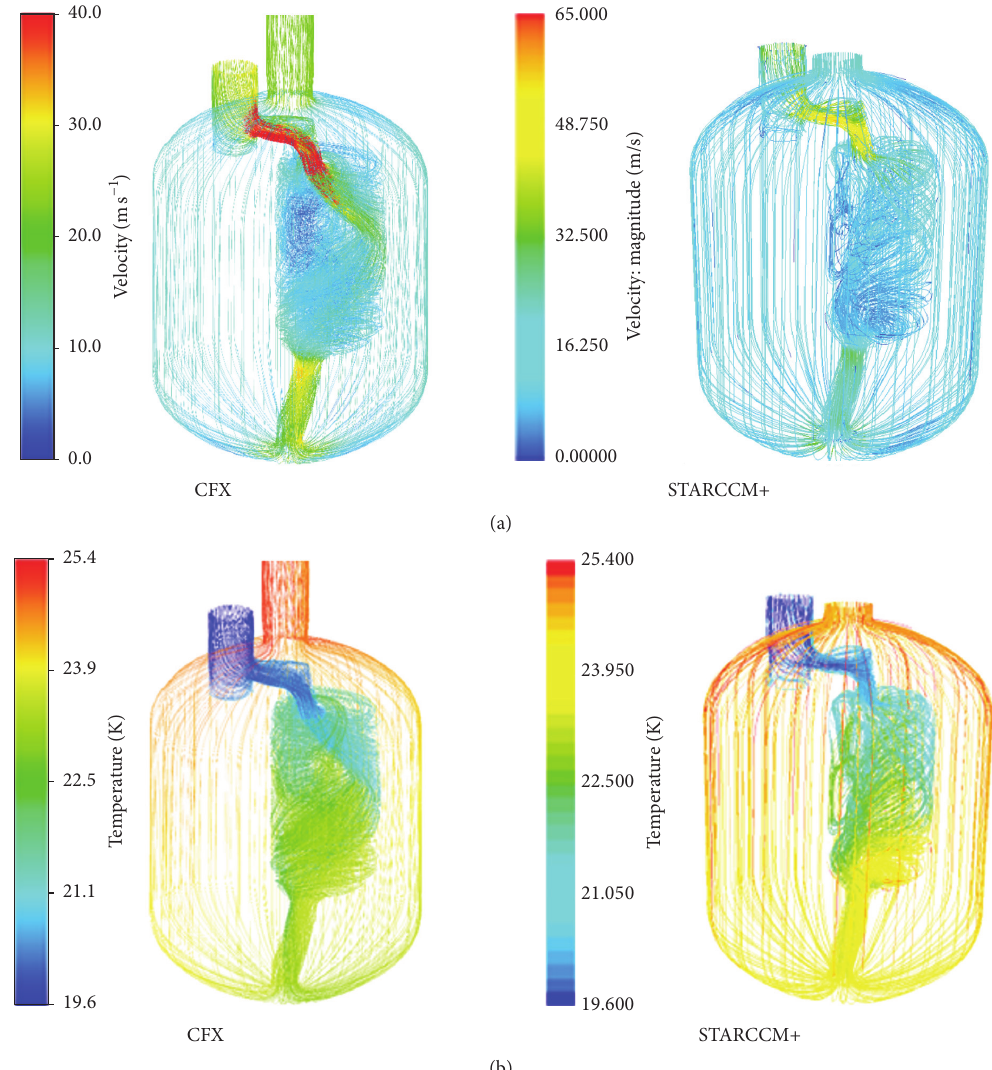
Figure 5: (a) Helium flow velocities as calculated using CFX and STARCCM+, (b) helium temperatures as calculated using CFX and